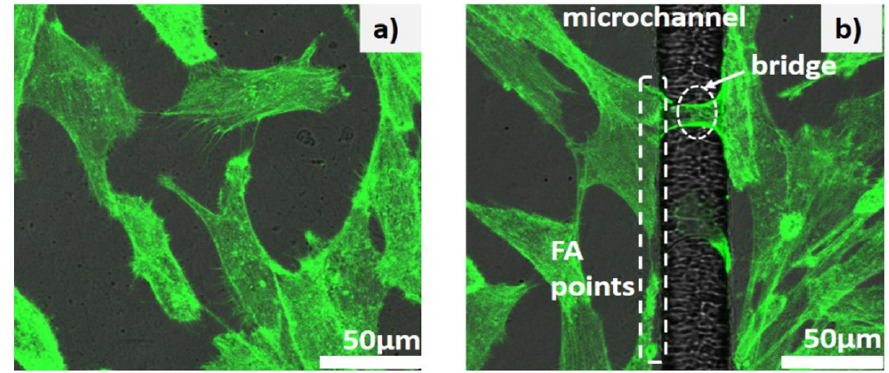
Figure 12. Cell alignment visualized after 48 h with rhodamine phalloidin for actin staining: ( a ) cells cultured on control, non-patterned surface and ( b ) patterned surface (F = 0.61 J/cm 2 , V = 3.8 mm/s), in the form of a microchannel.